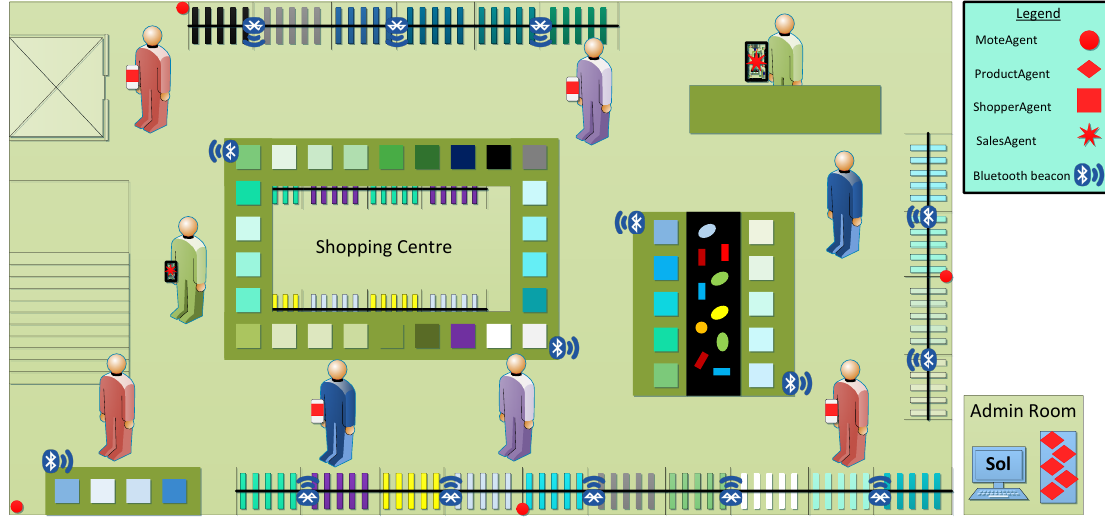
Figure 5. Overview of the multi-agent system of the smart shopping